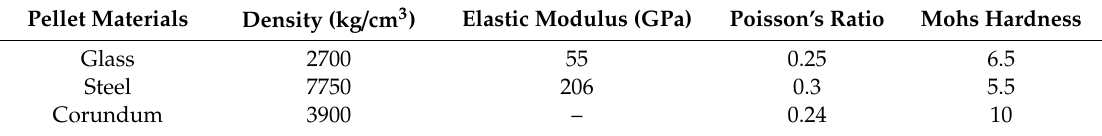
Table 2. Physical properties of pellet materials.